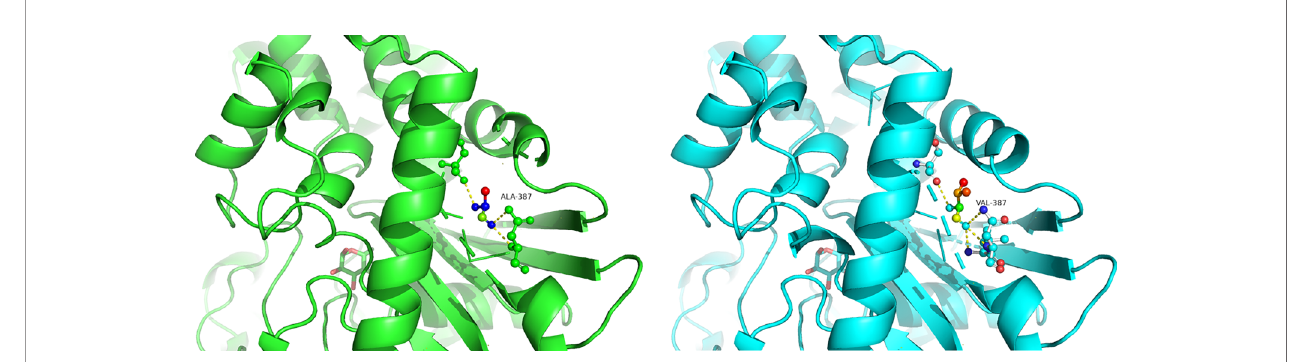
FIGURE 3 | Predicted computational tertiary structure. The wild genotype is presented on the left; the mutant genotype is presented on the right.